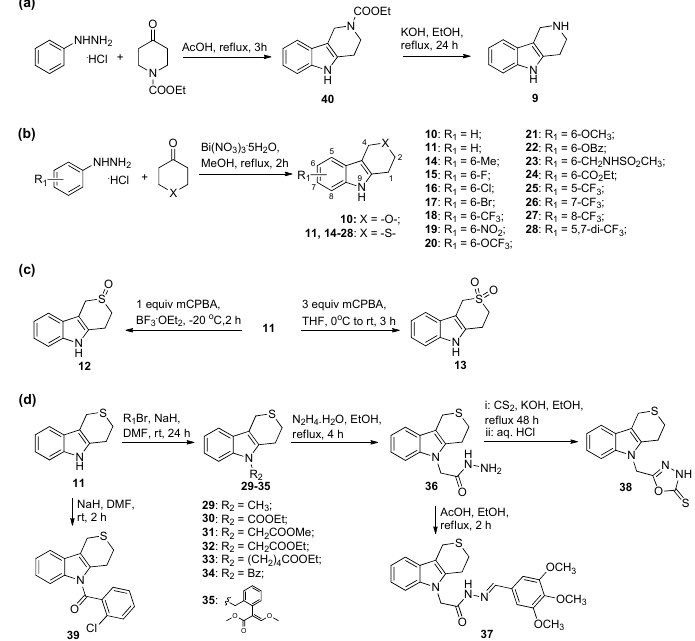
Figure 2. Synthesis of target compounds 9 – 39 .